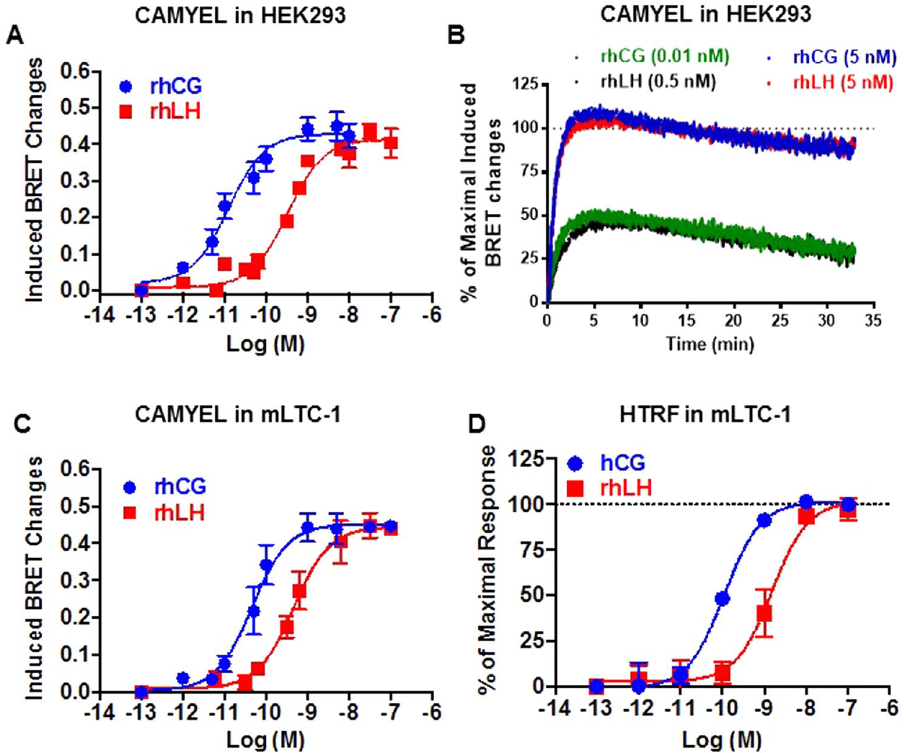
Figure 1. LH/CGR-mediated cAMP production. cAMP responses induced by rhCG and rhLH in HEK293 cells transiently co-expressing hLH/CGR and CAMYEL sensor ( A , B ) and in mLTC-1 cells transiently expressing CAMYEL sensor alone ( C ) or not ( D ). Cells were stimulated 30 minutes with increasing doses ( A , C and D ) or immediately with the indicated doses ( B ) of rhCG and rhLH, before cAMP production was measured by BRET ( A , B and C ) or HTRF ( D ). Data are means ± SEM of 3–8 independent experiments. The kinetic curves in panel B are representative of 3 experiments performed in triplicate.